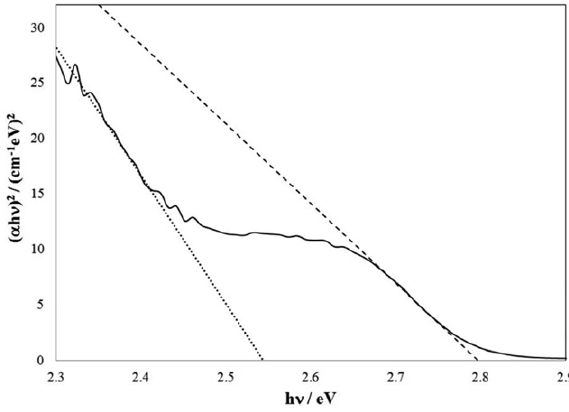
Figure 3. Plot (αhv) 2 vs. photon energy